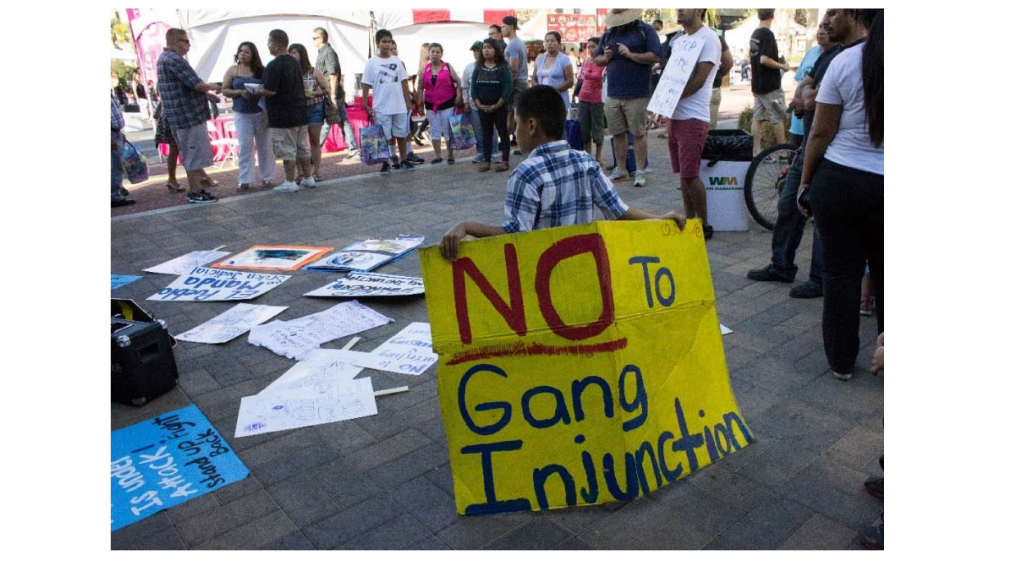
Figure 6. Downtown Santa Ana, 13 September 2014 (Source: Alexandra